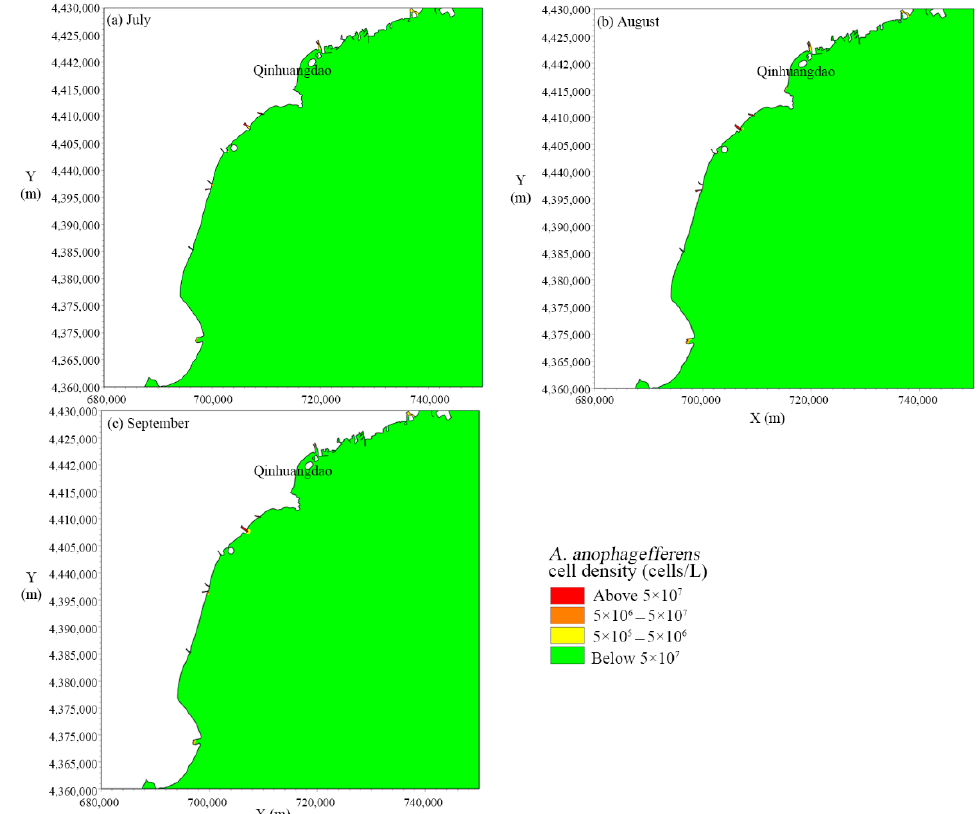
Figure 13. The distribution of A. anophagefferens cell distribution in July, August, and September 2021.